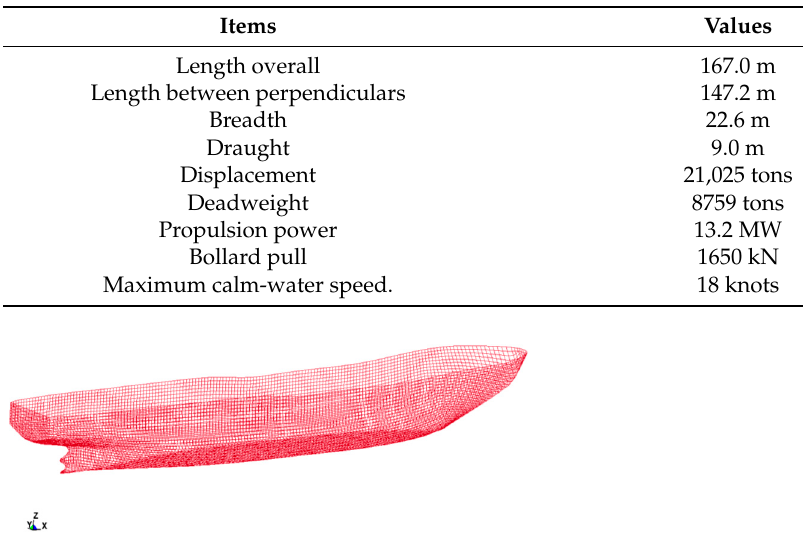
Figure 7. The numerical model used as a reference ship in the icebreaking simulations. Table 5. Primary dimensions of MV Xue